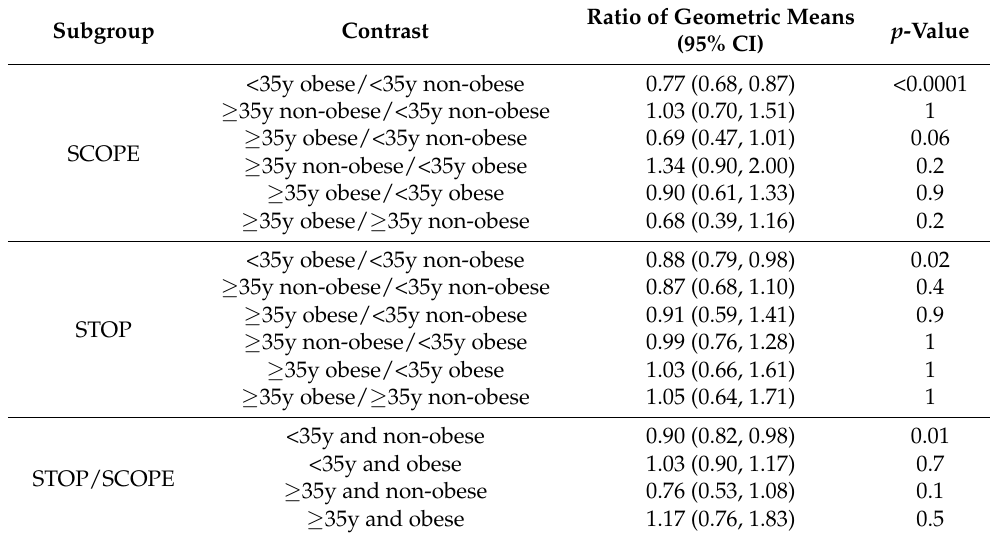
Table 9. Post hoc comparisons for placental growth hormone (GH2) in different maternal age and BMI categories within and between SCOPE and